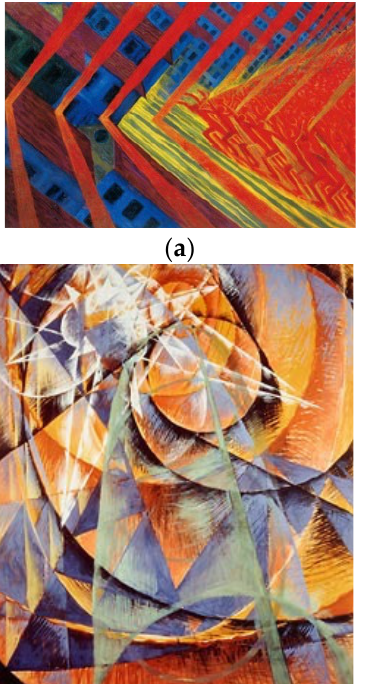
Figure 2. Three types of computer-generated art images. ( a ) A stained-glass-like image created by Mould [3]. (b) A tile-mosaic-like image created by Hausner [4]. ( c ) A rectangle-based Neo-Plasticism-like image created by Liu et al. [5].